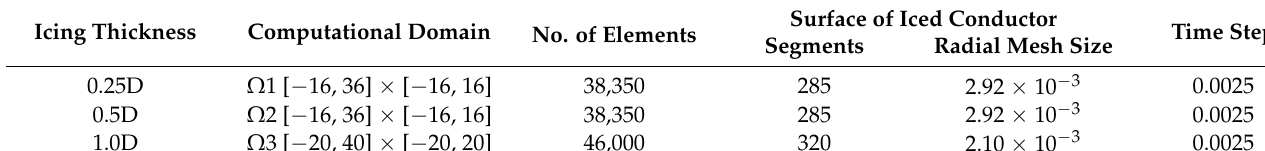
Table 3. Computational domain and grid parameters.